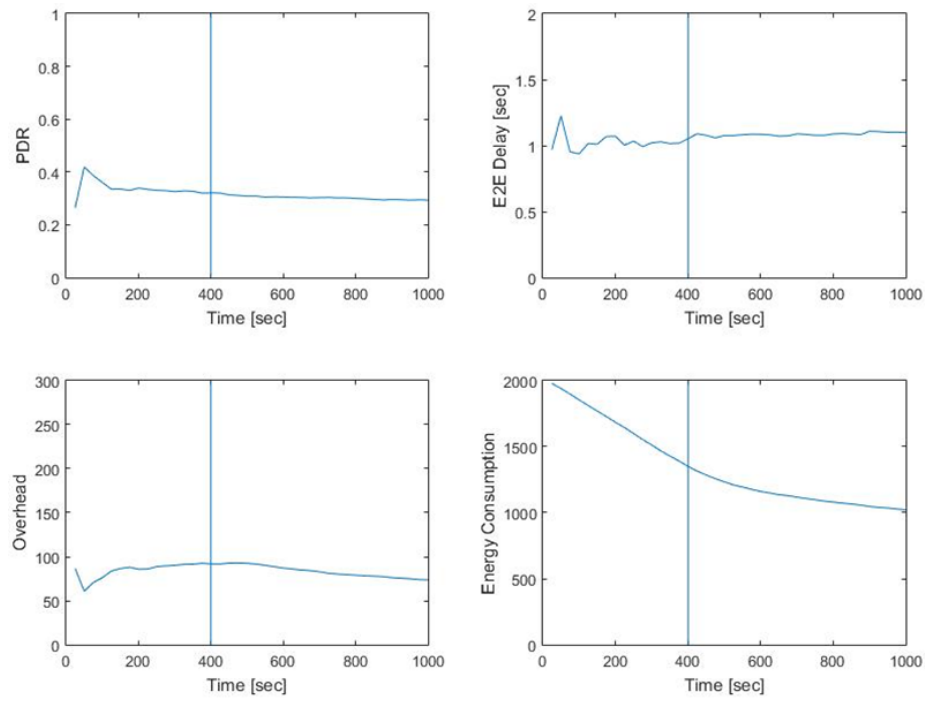
Fig. 5. Evaluation of OLSR protocol based on 30 mobile sensor